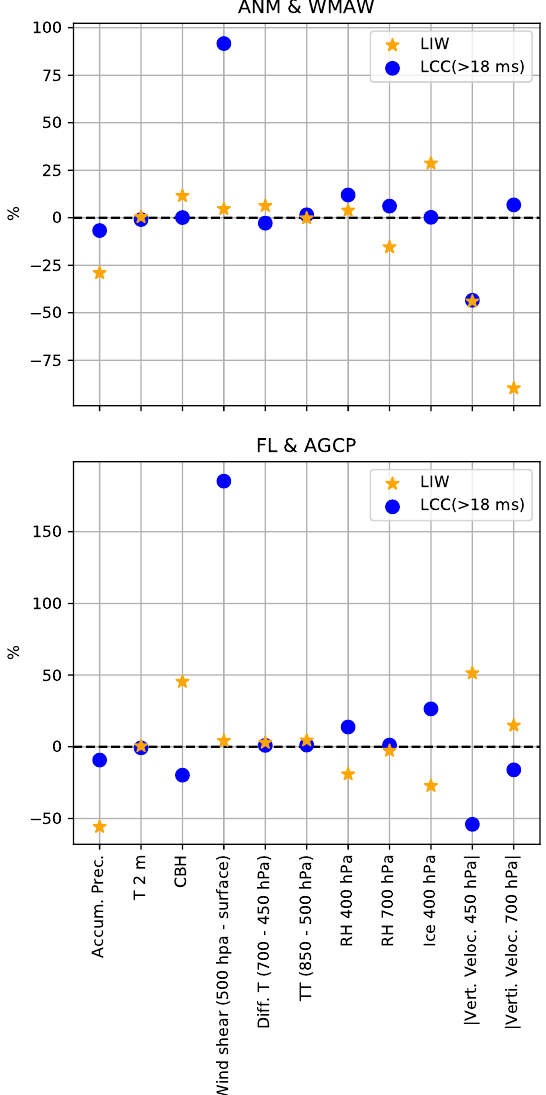
Figure 9. Variation with respect to the median of all the CG strokes of some meteorological parameters for thunderstorms producing LIW and LCC (>18 ms) lightning. Note that LIW were analyzed over the regions of Arizona and New Mexico and over Florida, while LCC (>18 ms) lightning were examined in the WMAW and AGCP